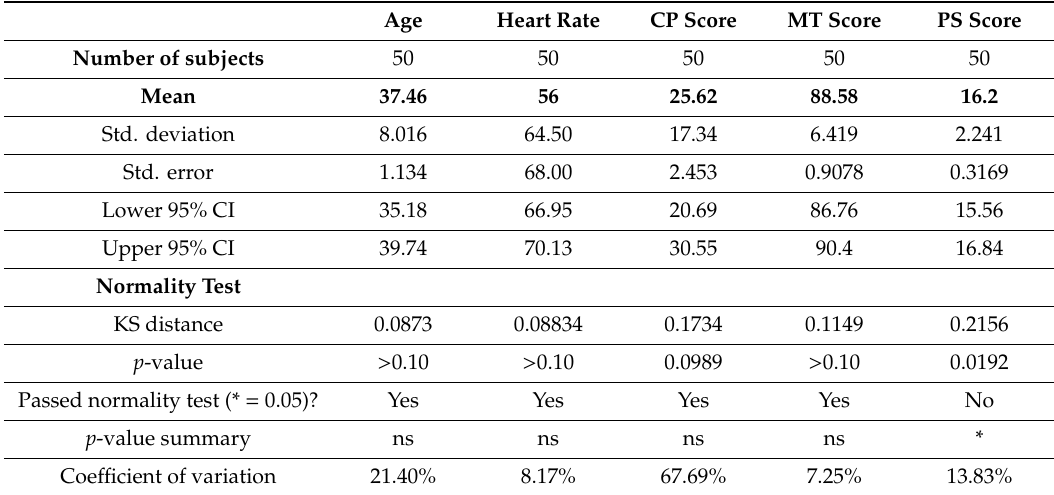
Table 1. Baseline demographic and e ffi cacy-outcome measures. Note: CP, concentration performance; MT, memory test; PS, perceived stress; ns, not significant.